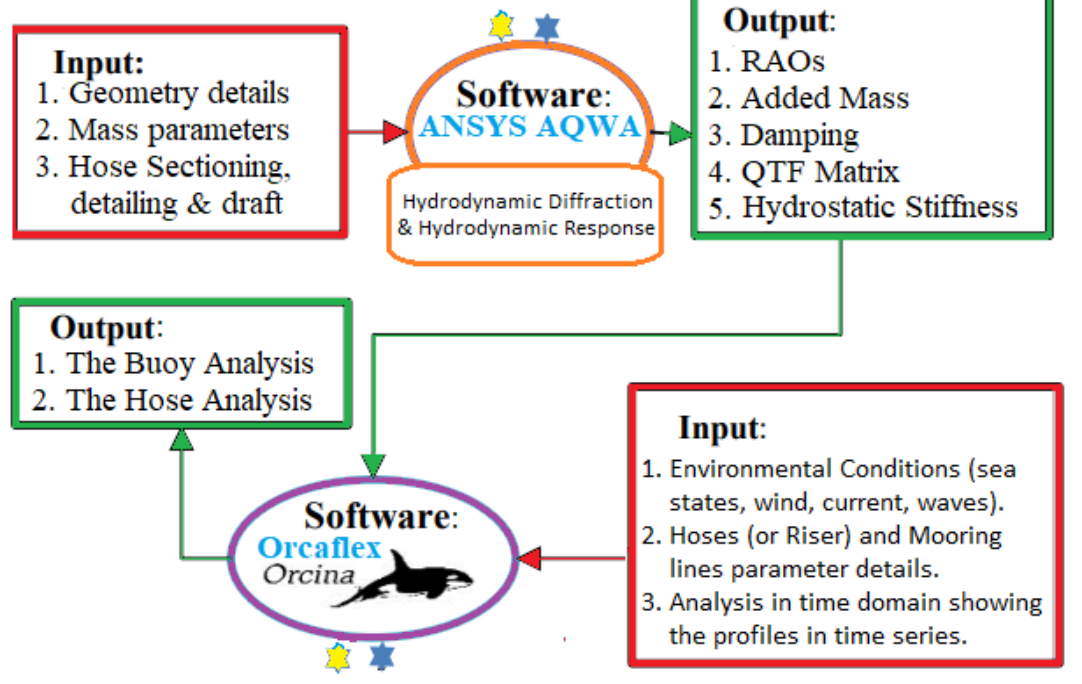
Figure 18. Flow diagram of the methodology for the design analysis.